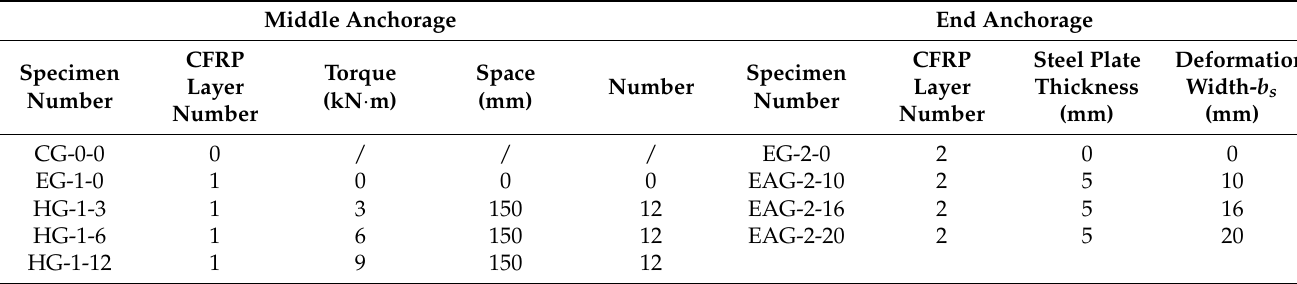
Table 3. Specimen numbers and strengthening configurations.